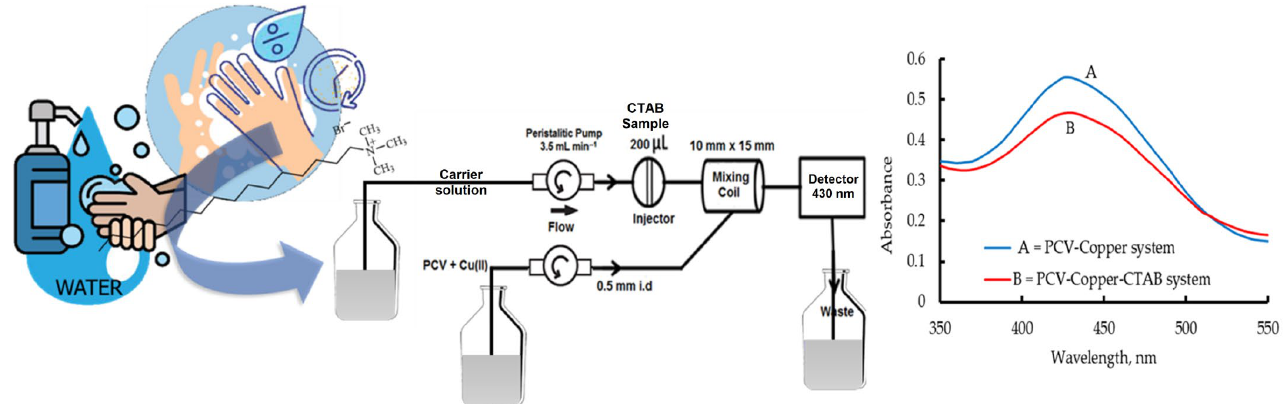
Figure 2. Sensing strategy for the quantitative determination of CTAB in different environmental samples.